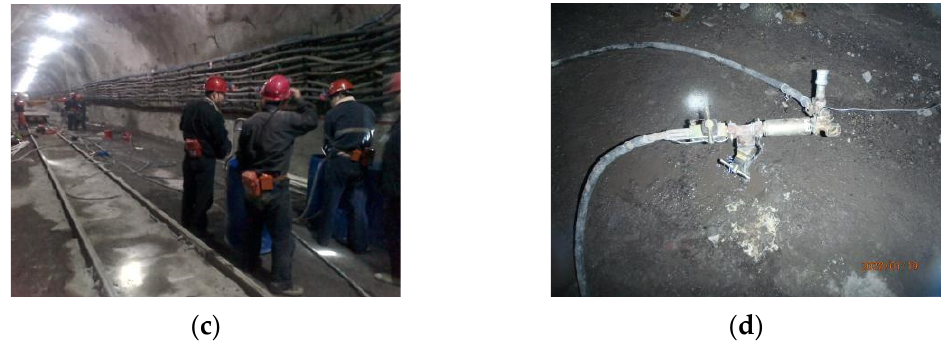
Figure 5. Laboratory grouting model experiment and actual grouting process underground. ( a ) Laboratory grouting model. ( b ) Actual underground grouting batching. ( c ) Carrying out underground grouting. ( d ) Grouting orifice.